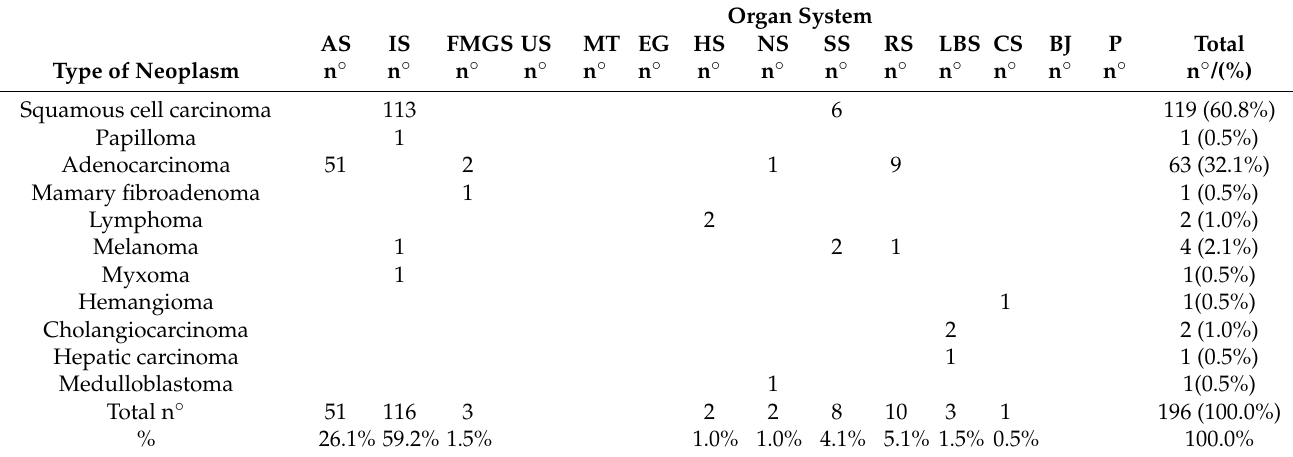
Table 6. Distribution of neoplasms in sheep according to the organ system. Organ